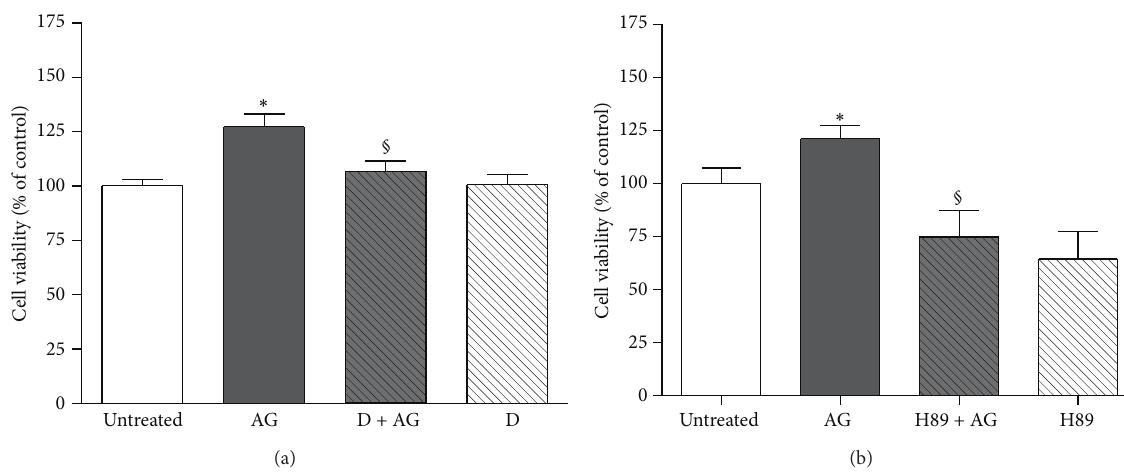
Figure 5: Effect of pretreatment with (a) D-Lys 3 -GHRP-6 (D, 10 −7 M, 30min before AG) or (b) the PKA inhibitor H89 ( 2 × 10 −6 M, 30 min before AG) on the stimulatory action of ghrelin (AG, 10 −10 M) on rat osteoblast-like cells (rOB) viability. Cell viability was measured by MTT assay. Data are expressed as the percentage relative to control and are the means ± SEM of four replicates within a single experiment that was repeated at least three times. ∗ 𝑃 < 0.05 versus untreated cells; ∘ 𝑃 < 0.05 versus